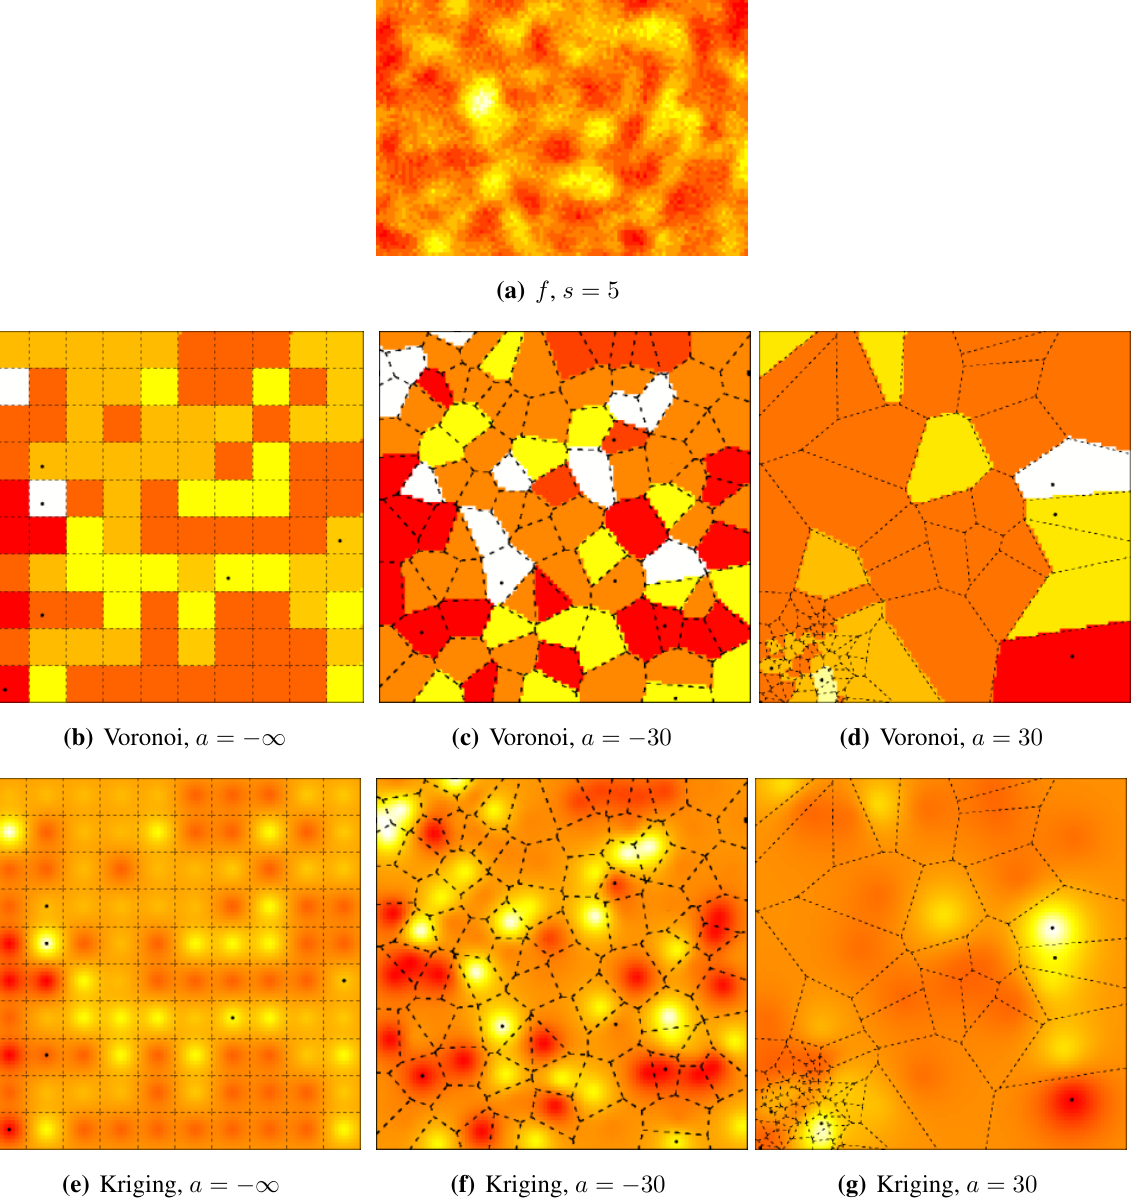
Figure 6. The influence of sensor deployment using SKATER, fine data